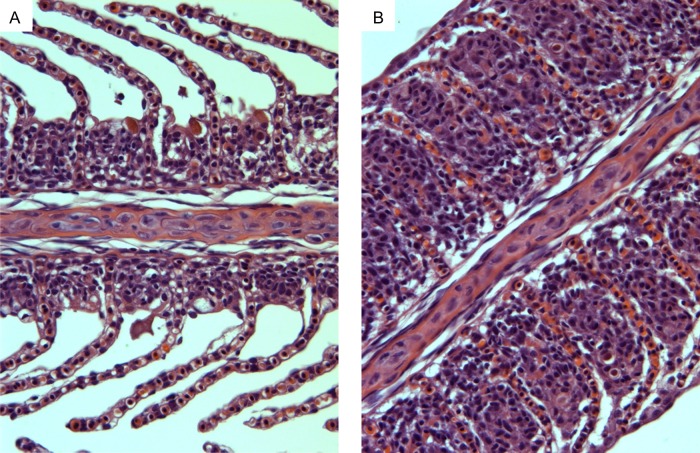
Light microscopy image showing increases in the interlamellar cell mass. Haematoxylin- and eosin-stained Arctic grayling gill filaments in freshwater (A) and after 24 h exposure to 50% seawater (17 ppt; B).